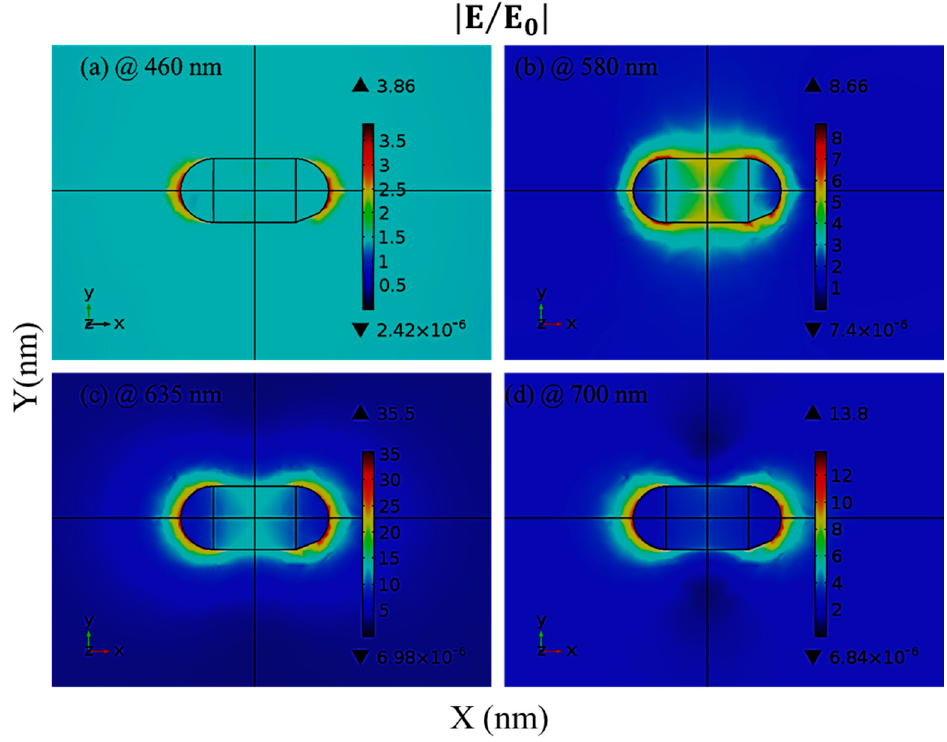
Figure 2. ( a ) Electric field enhancement (V/m) ( a ) at λ = 460 nm, ( b ) at λ = 580 nm, ( c ) at plasmonic resonance ( λ = 635 nm) and ( d ) at λ = 700 nm for the gold nanorod of 35 nm length under p-wave illumination.